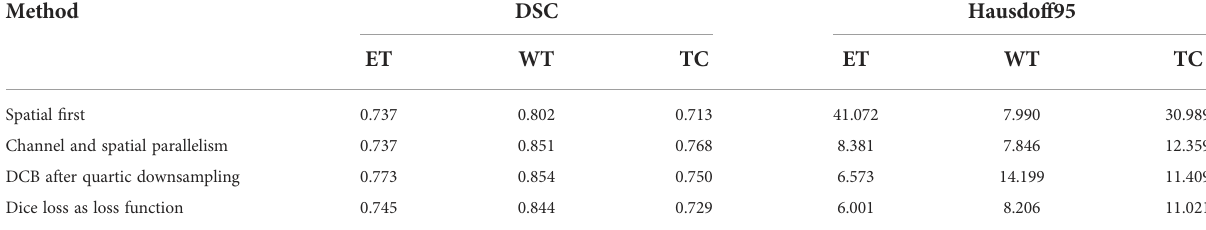
TABLE 5 Control experiment on BraTS 2020